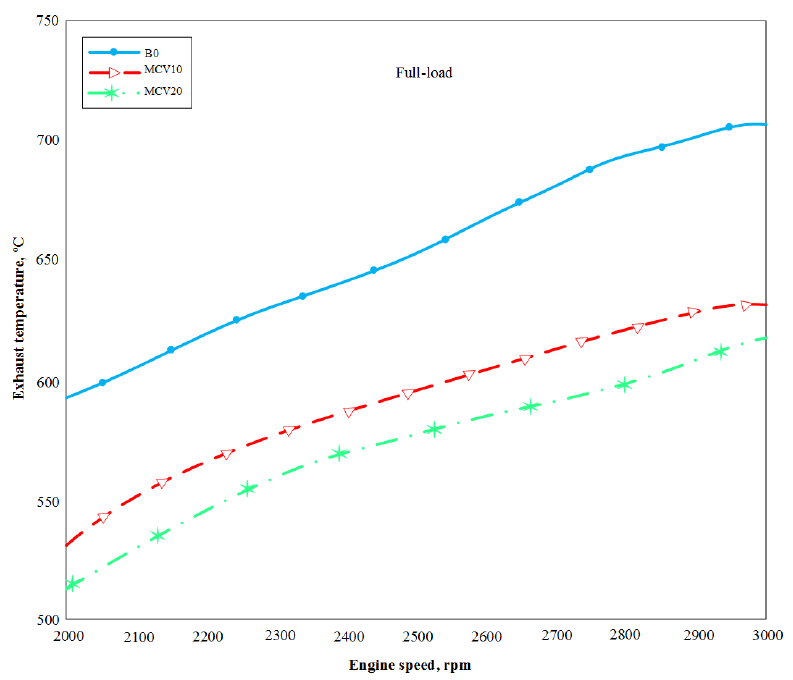
Fig. 11. Exhaust gas temperature of MCV biodiesel blends at